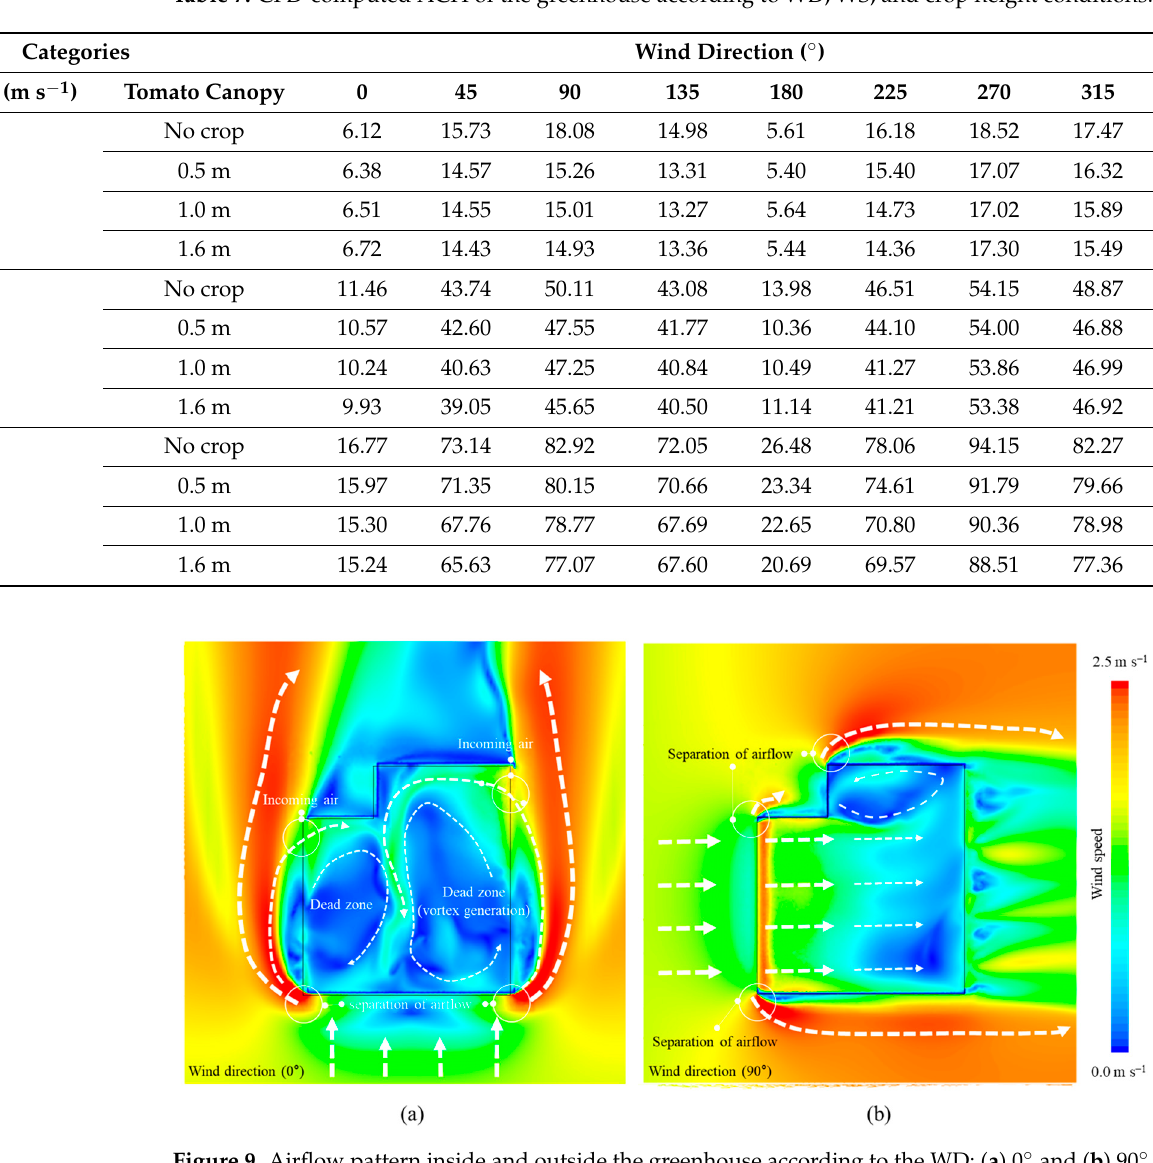
Figure 10. Airflow pattern inside and outside the greenhouse according to the WD of 45° (WS: 3.0 m s − 1 , and crop height: 1.0 m).